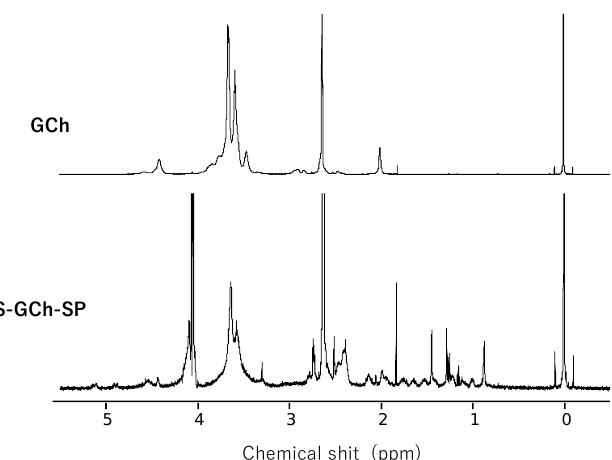
Figure 3. 1 H-NMR spectra of GCh-SP and S-GCh-SP. The mixture of dimethylsulfoxide (DMSO)-d 6 /D 2 O (1:1, v / v ) was used as a solvent.